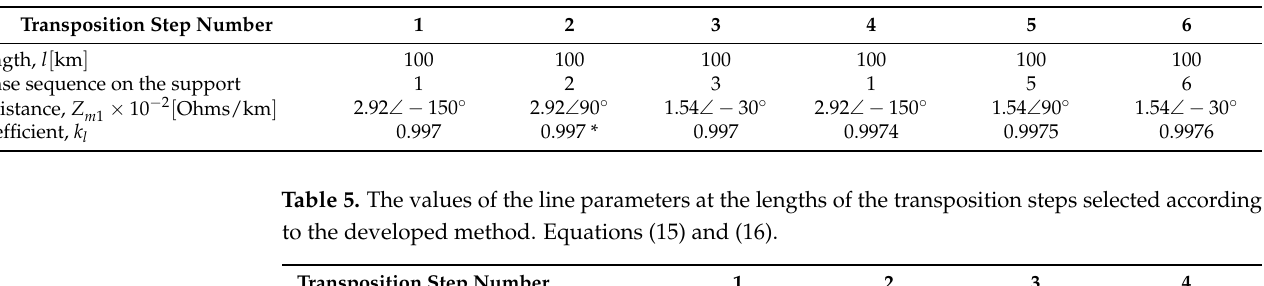
Table 4. Line parameter values at six equal steps of the full transposition cycle.